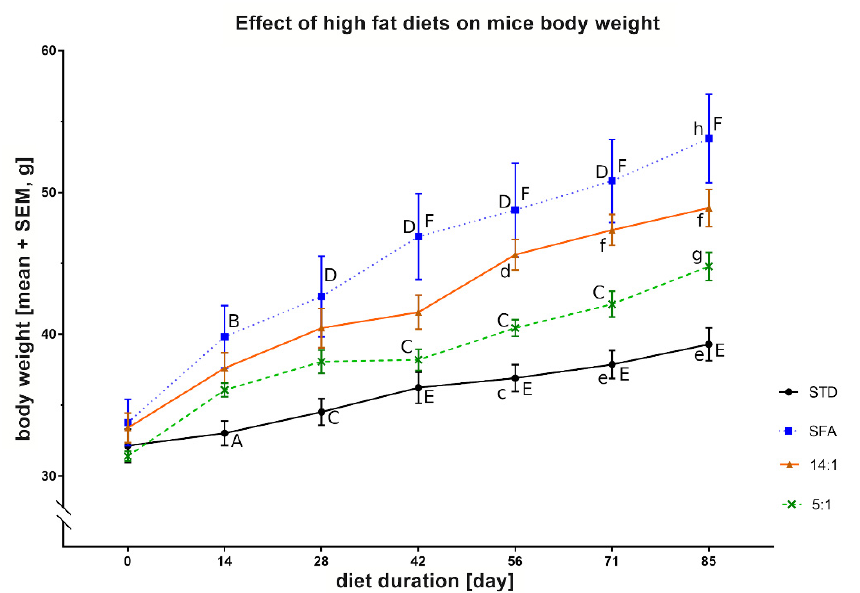
Figure 2. Body weights of mice fed standard (STD), high-fat high-saturated (SFA) diets and high-fat high-polyunsaturated diets with LA/ALA equal 14:1 and 5:1 (14:1 and 5:1, respectively) during approximately 3 months of the experiment. Values are means ± SEM, n = 8. Values with a different letter differ significantly at the same diet duration time point: AB — p < 0.05; CD or cd — p < 0.01; EF or ef or gh — p < 0.001. Table 2. Plasma biochemical parameters after three-month diets—the standard (STD), the experimental diets (SFA, 14:1 and 5:1)—expressed in arithmetic mean values (SD) (8 per